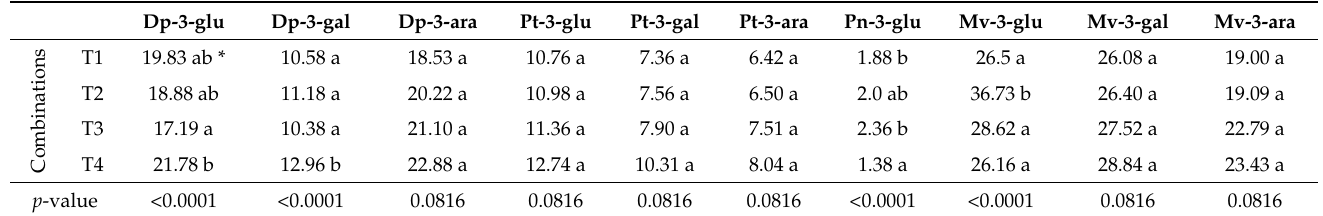
Table 6. Content of anthocyanin group active compounds in relation to fertilizer combination (mg · 100 g − 1 FW). * Data followed by the same letter are not significantly